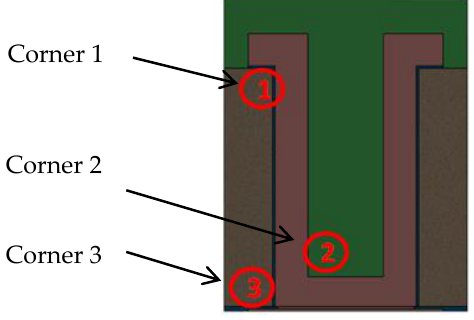
Figure 6. Schematic showing the critical locations of TSV Type A: Corner 1, Corner 2 and Corner 3.